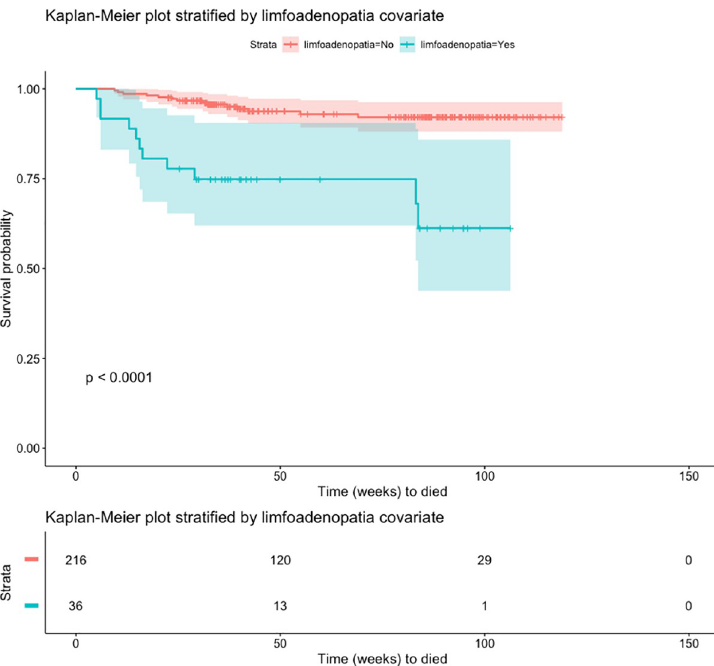
Fig 2. Kaplan-Meier curve showing probability of survival over time stratified by occurrence of radiologist observation of lymphadenopathy. Shaded area reflects the 95% confidence interval of each survival curve. The table show the number of cases at each time point. P-value shows the log-rank test comparing all survival curves.